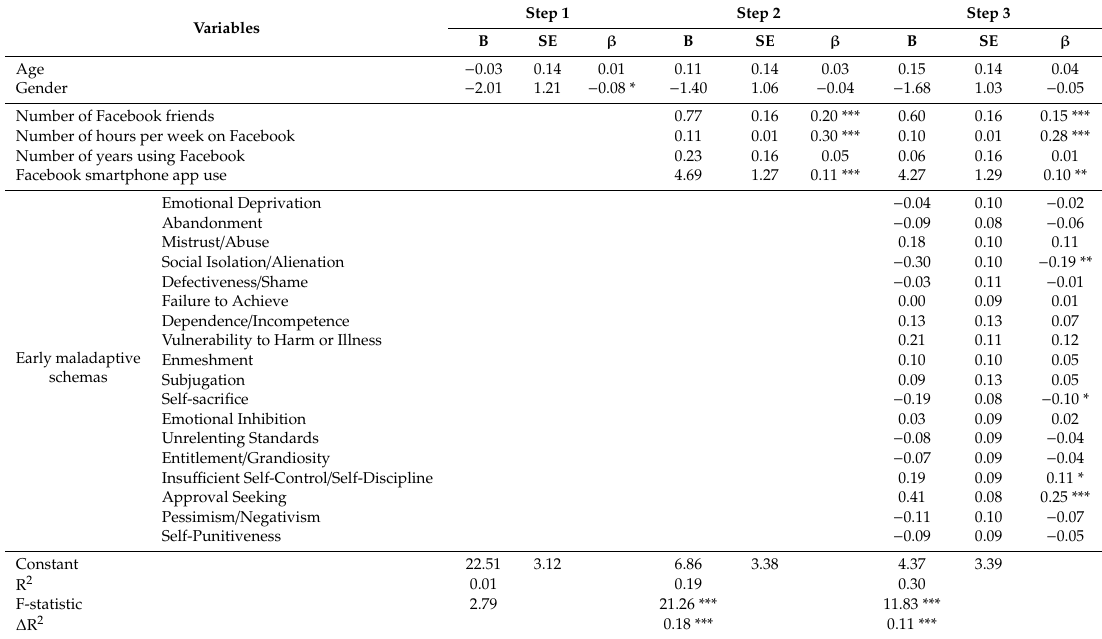
Table 3. Results of hierarchical